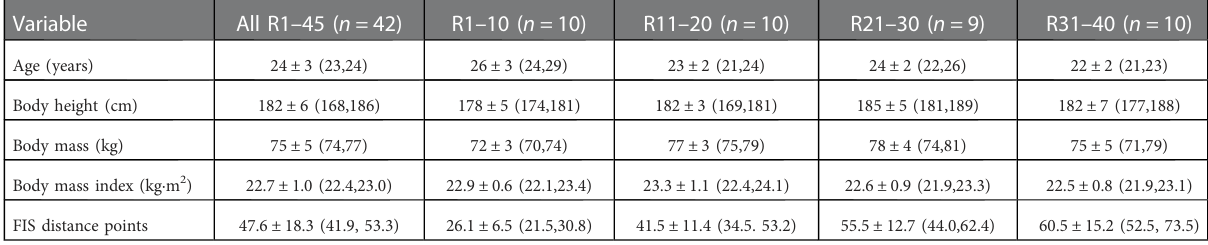
TABLE 1 Anthropometrics and performance levels [mean value±standard deviation (mean limits of con fi dence)] of the analyzed cross-country skiers in a 21.8 km mass-start competition, both overall and for the different performance-groups.